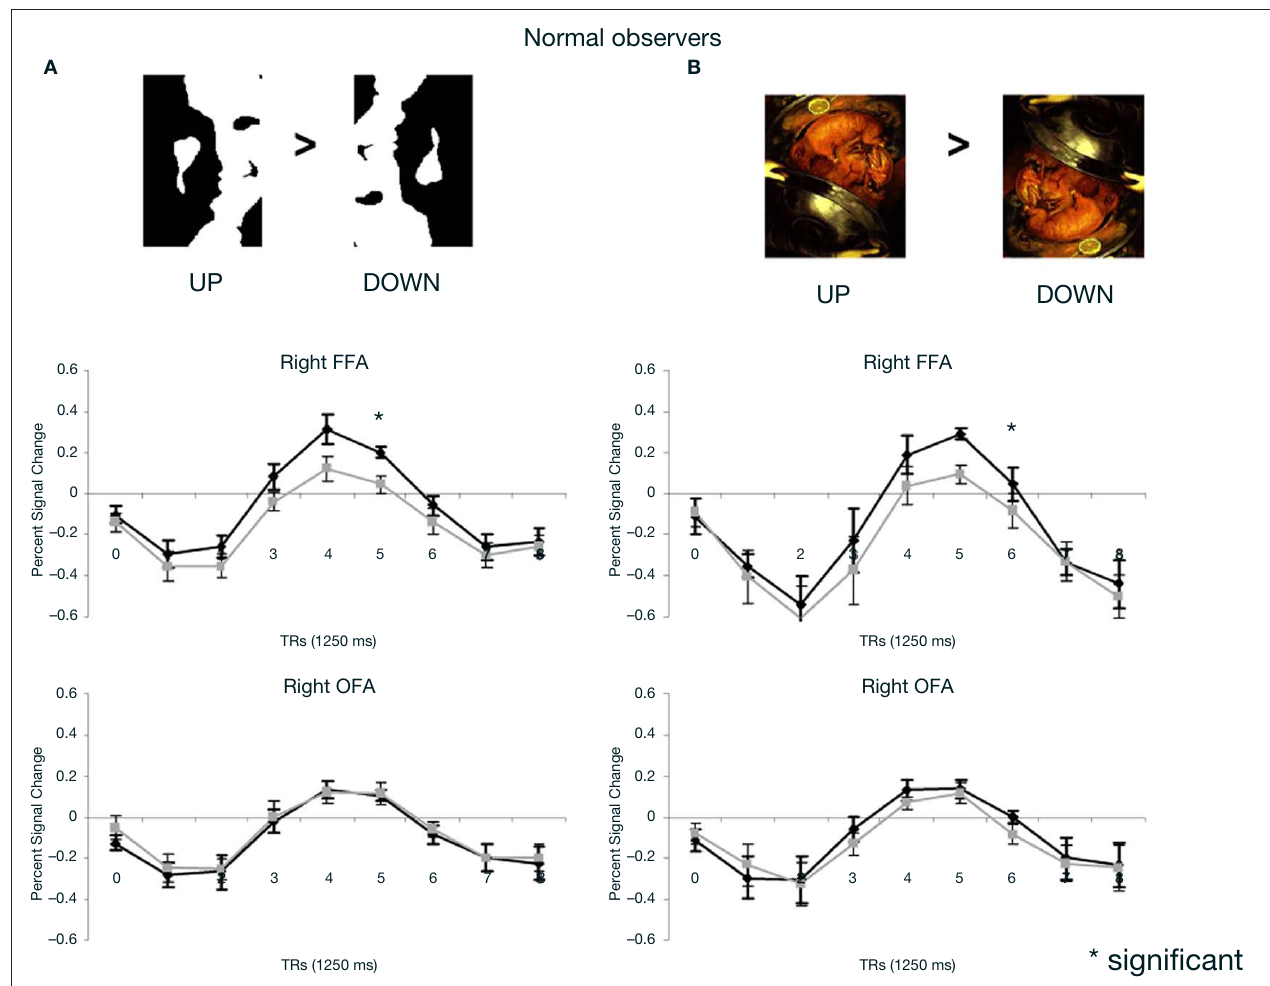
Figure 4 | (A) Response to upright (“face”) and inverted (“non-face”) Mooney stimuli in the right FFA and OFA for the group of normal participants in the experiment. Note that while the right FFA showed a significantly larger response to Mooney faces, as shown previously (e.g. Kanwisher et al., 1998), there was no such effect in the right OFA. (B) The same observations were made for Arcimboldo